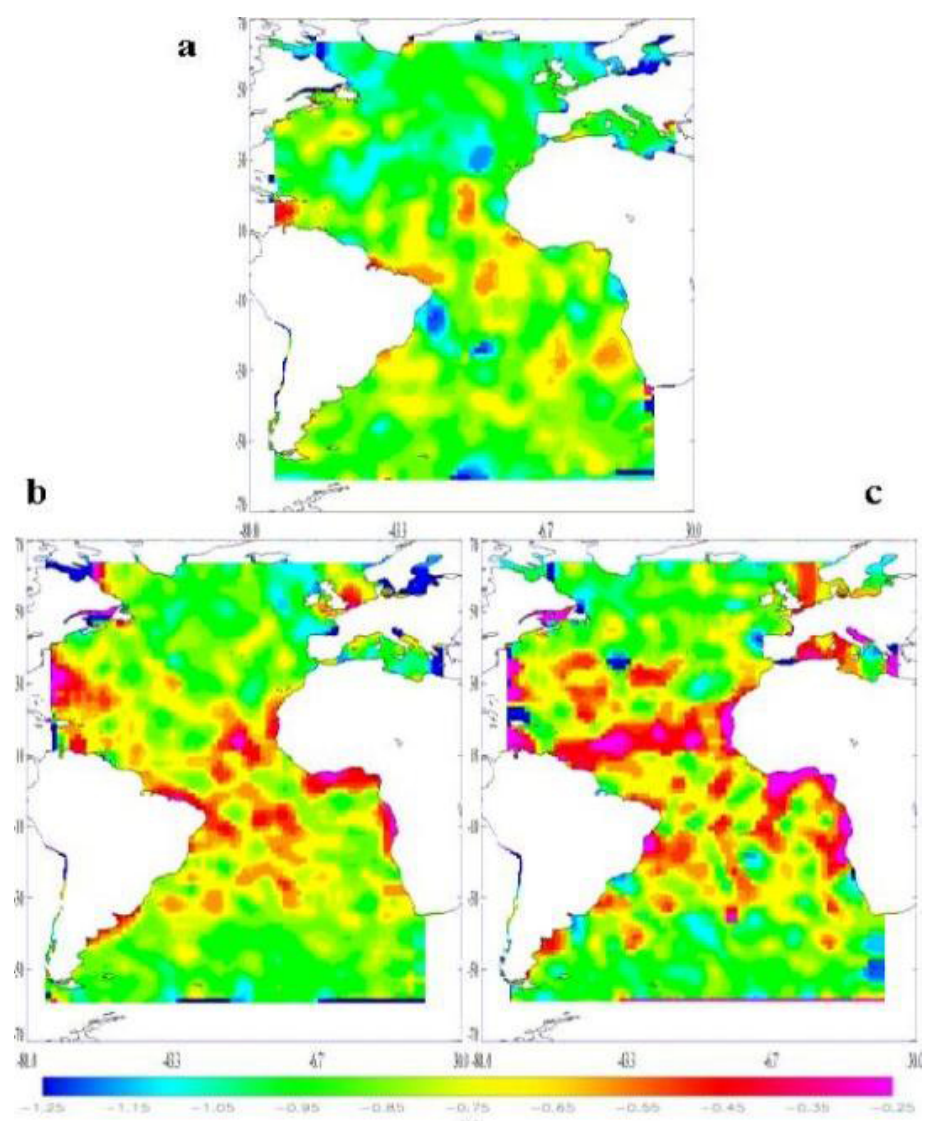
Fig. 9. Geographical distribution of BF in the Atlantic Basin, obtained via EOFD for the three time samplings considered. (a) 1t = 35days, (b) 1t = 11days and (c) 1t =